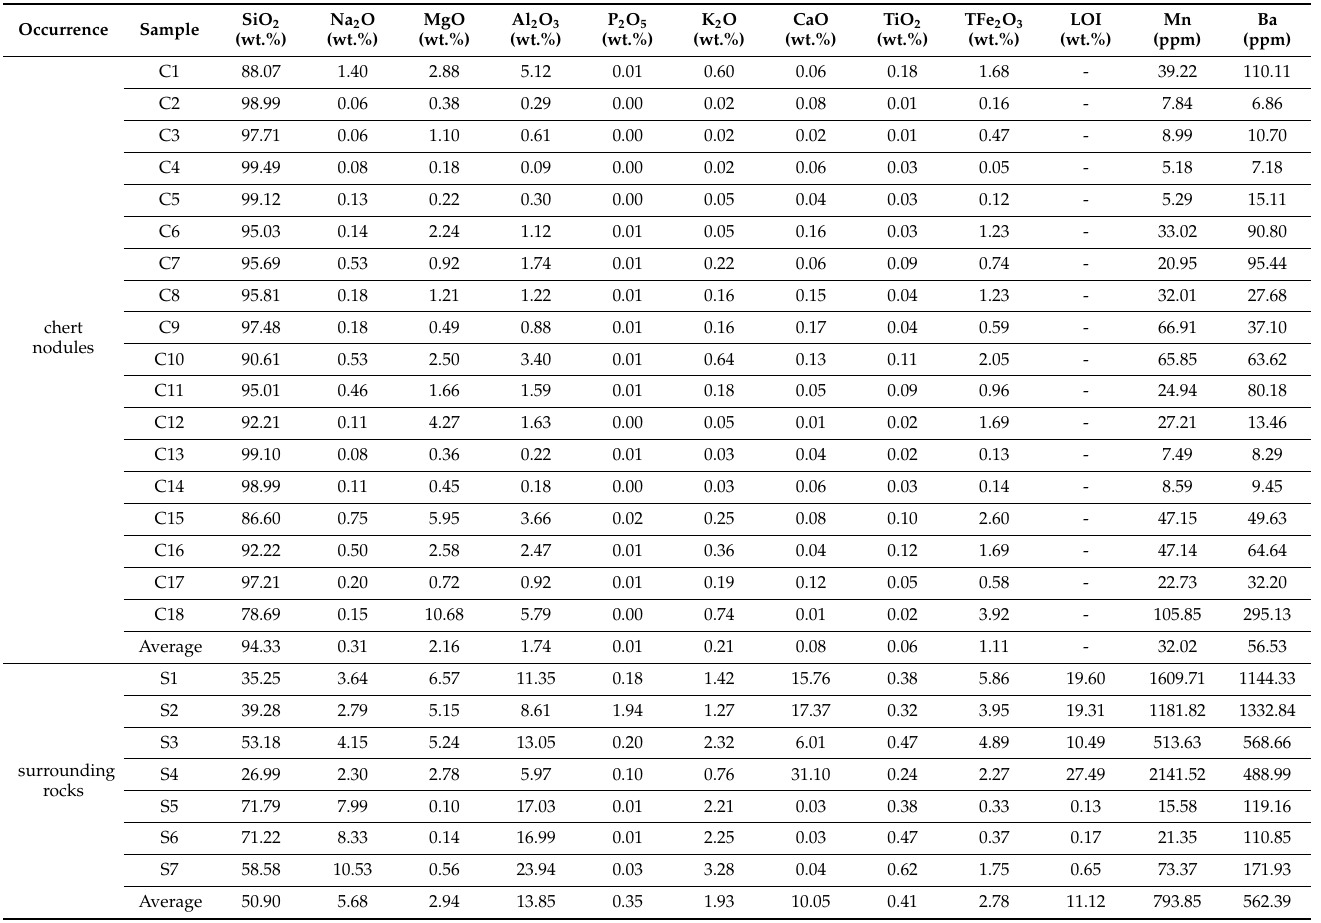
Table 1. Major (wt%) and trace elements (ppm) of chert nodules and surrounding rocks in the Lucaogou Formation, Junggar Basin. The symbol “-“ indicates the unmeasured